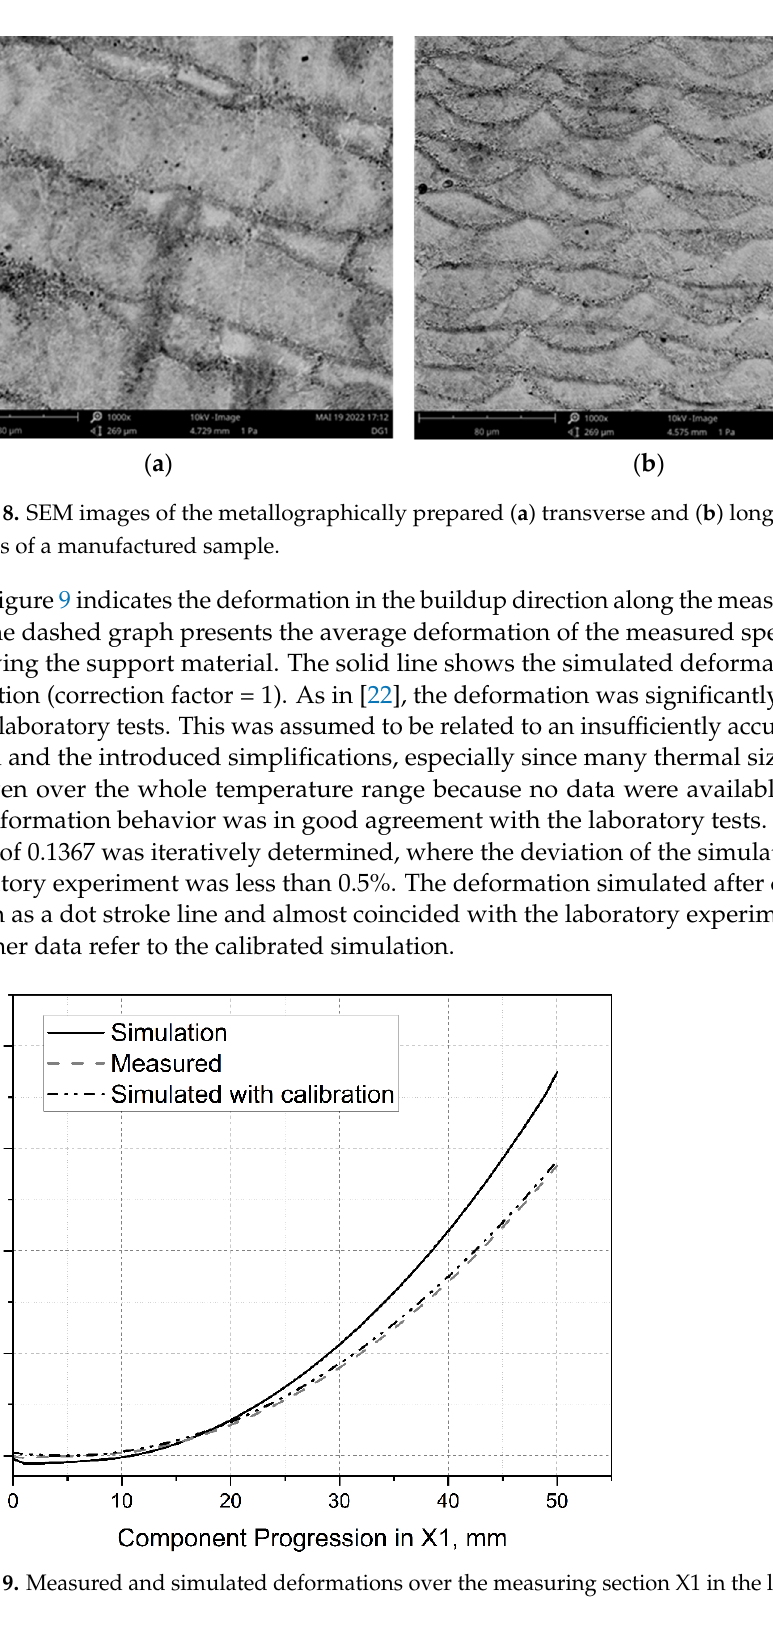
Figure 7. Stress–strain diagram of the examined specimens.